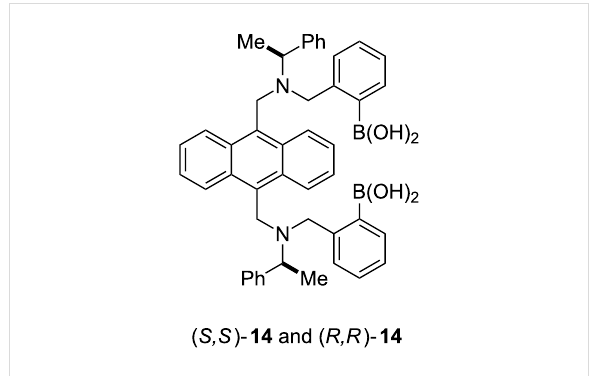
Figure 10: Chiral discriminating sensor (relative stereochemistry shown) constructed using a good fluorophore